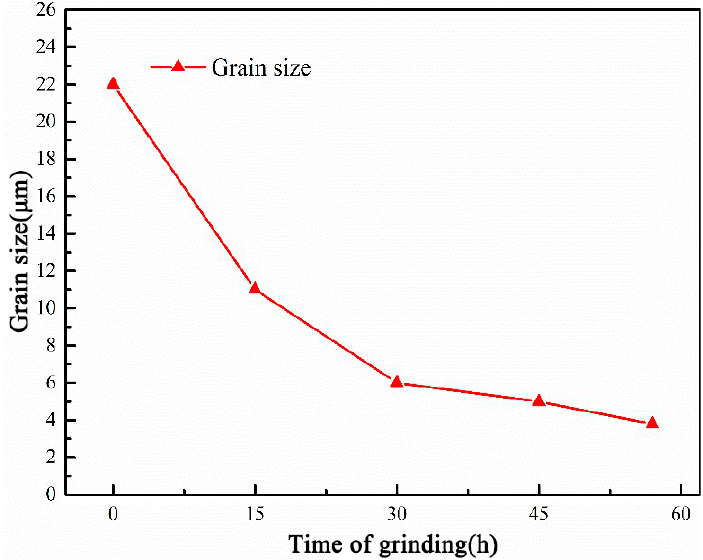
Figure 6. Microstructure of CNTs/Mg composites fabricated from Mg powder grinded for differ-